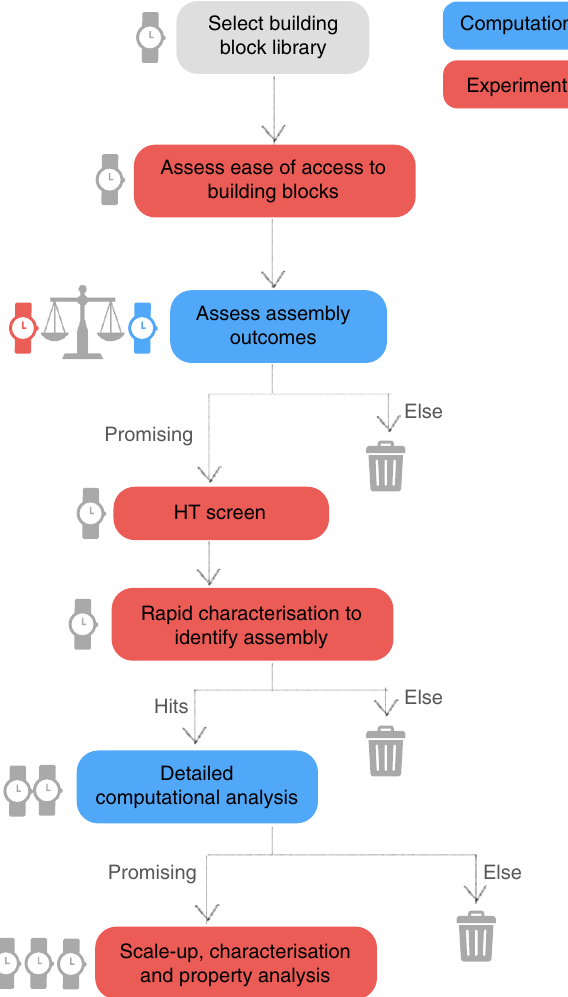
Fig. 6 Proposed work fl ow for the fusion of high-throughput automated synthesis with computation for the accelerated discovery of supramolecular materials. Experimental stages are shown in red and computational stages in blue. Approximate time cost for each step is indicated (1 clock = quick; 3 clocks = time-intensive). In this fi rst study, all building block combinations were investigated to validate the approach, but the future goal is to remove low-value targets as early as possible, thus saving time and cost. First, an initial building block library is selected, and their ease of synthesis is assessed. Then, a judgement is made on a sliding scale as to whether a very rapid computational assessment of properties is conducted (e.g., test for shape-persistence in assumed topology), up to a full analysis of multiple assembly outcomes, detailed energetic assessment of the likely revolves around the synthetic effort in obtaining a given building block.